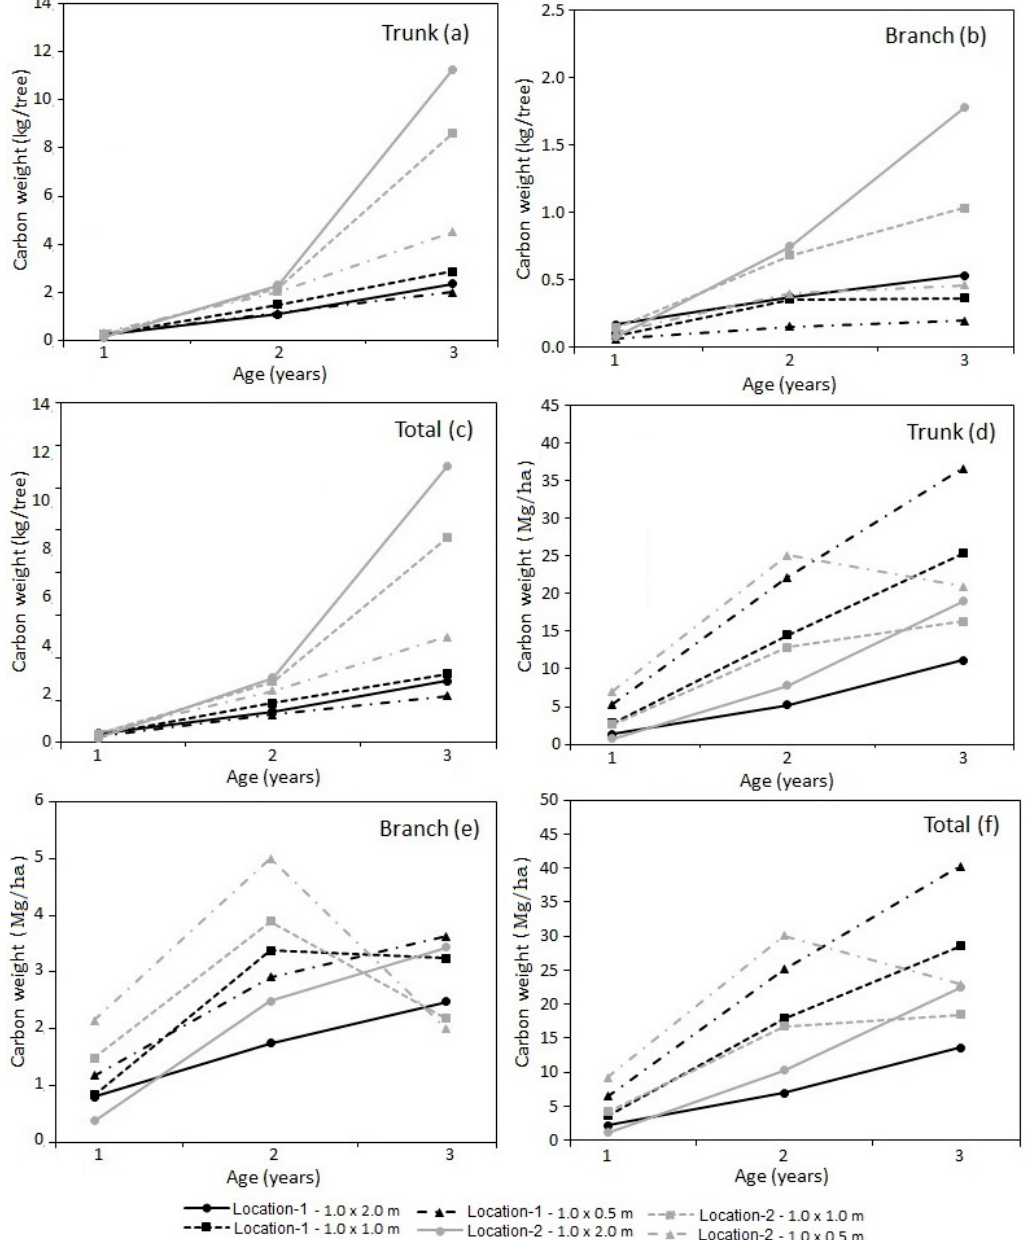
Figure 4. Carbon capture distribution per tree ( a – c ) and hectare ( d – f ) in short rotation Gmelina arborea plantations in two different locations in Costa Rica.